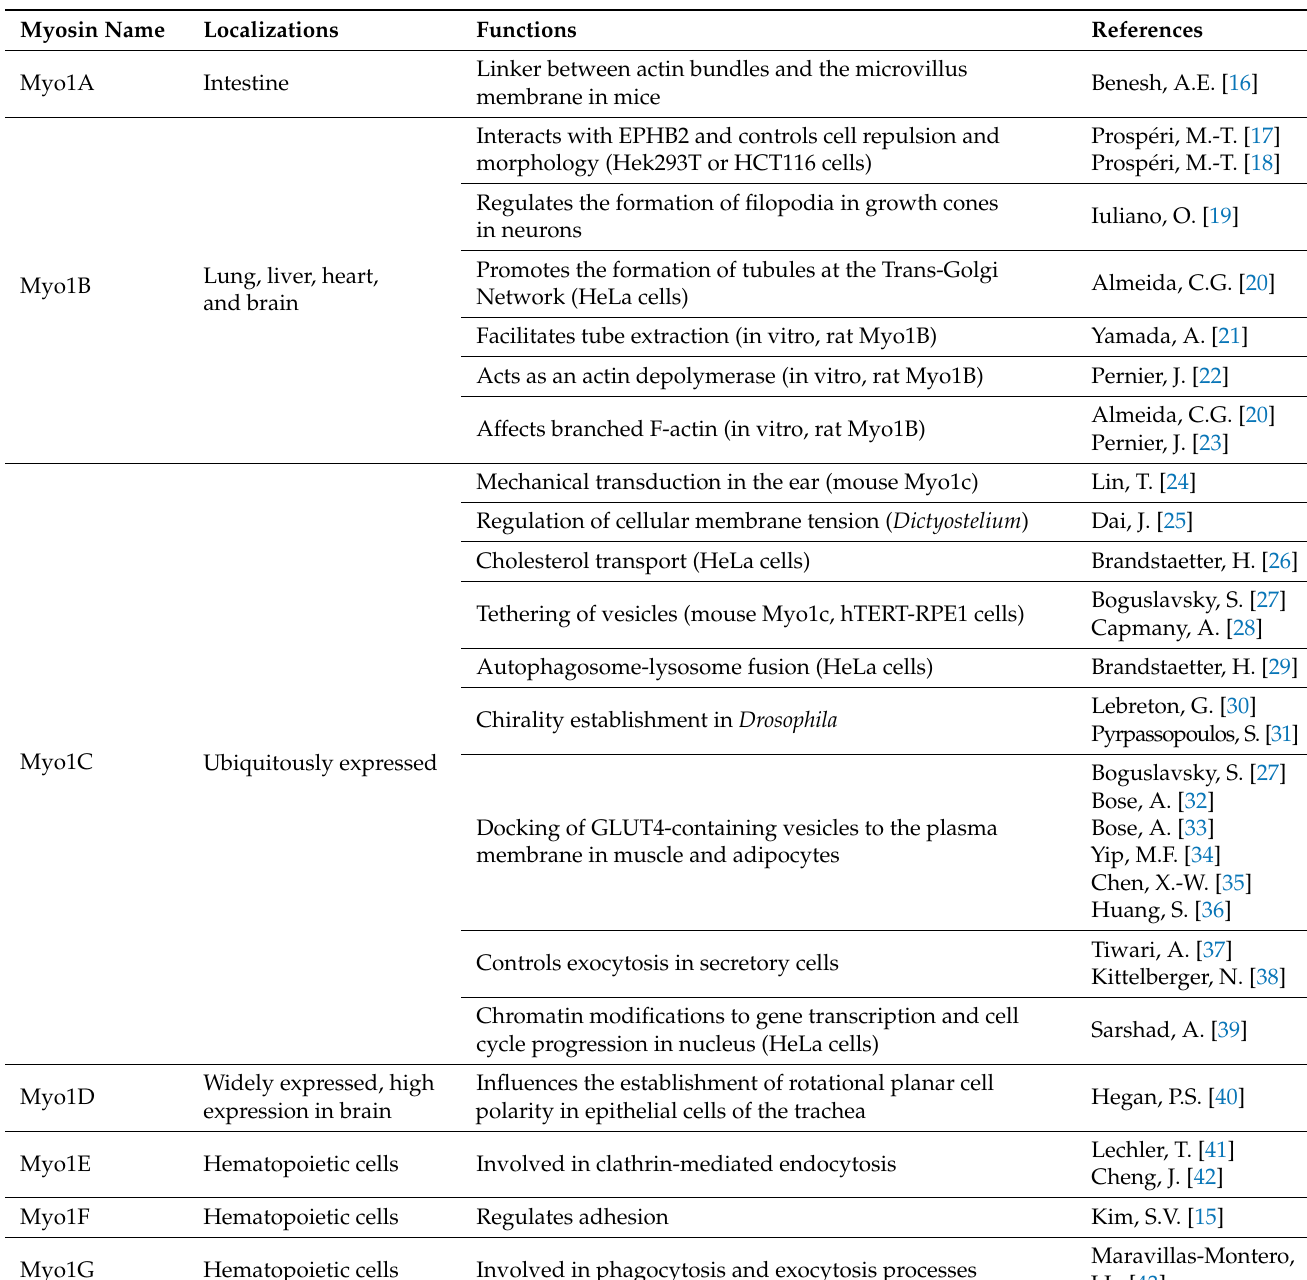
Table 1. Localizations and functions of myosin 1